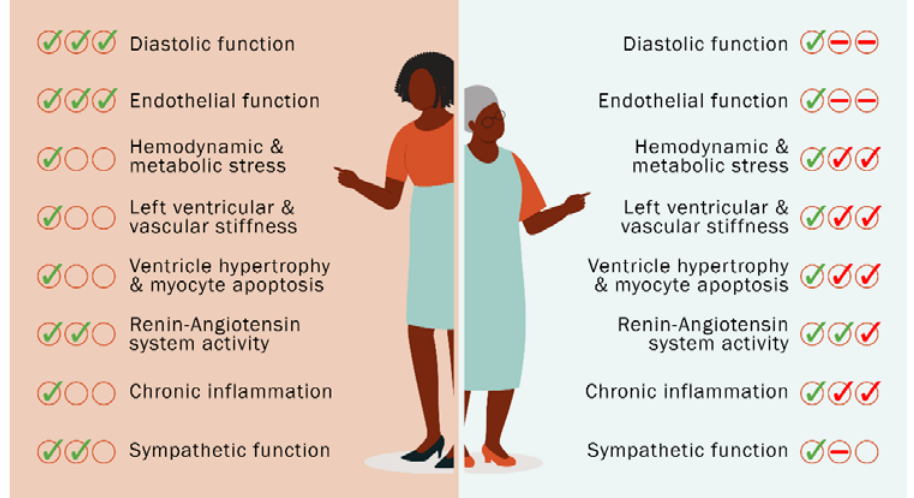
Figure 1. Cardiovascular parameters of premenopausal healthy women (left panel) are altered after menopause (right panel) and underlie the increased risk of HFpEF and mortality in this population, with either reduction (red dashes) or pathological exacerbation (red